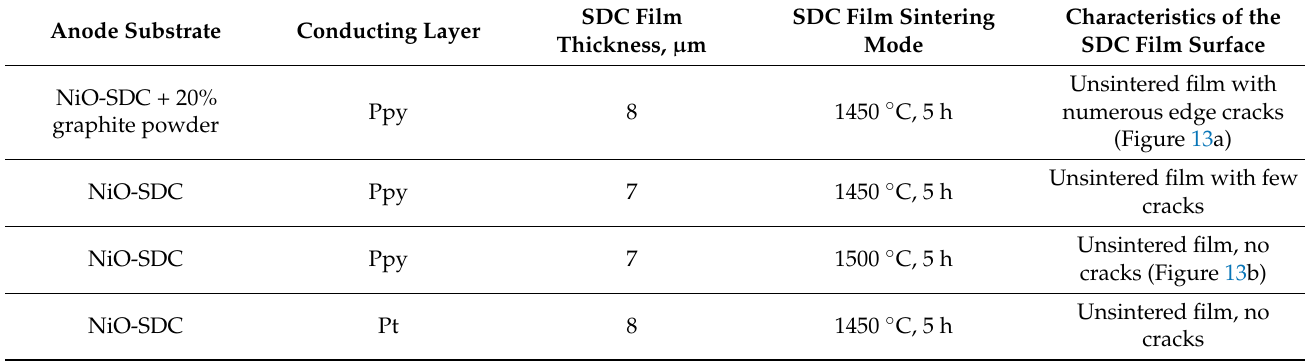
Table 3. Features of co-sintering of the SDC layer deposited on the anode porous NiO-SDC substrates pre-sintered at decreased temperatures and with different conducting layer.